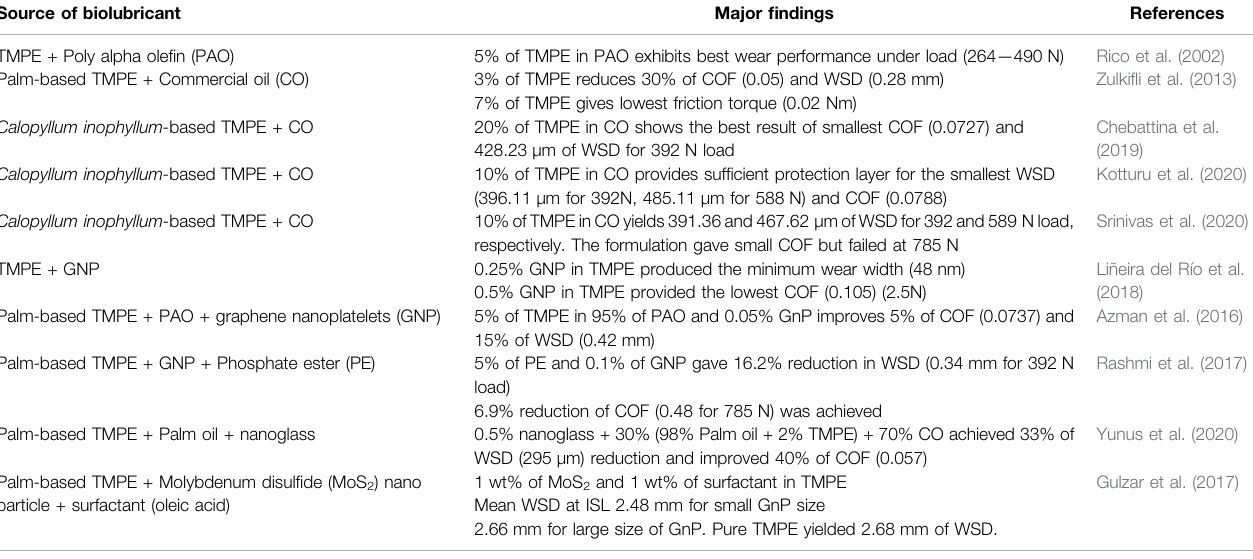
TABLE 6 | Tribology properties of TMPE-based engine oil.